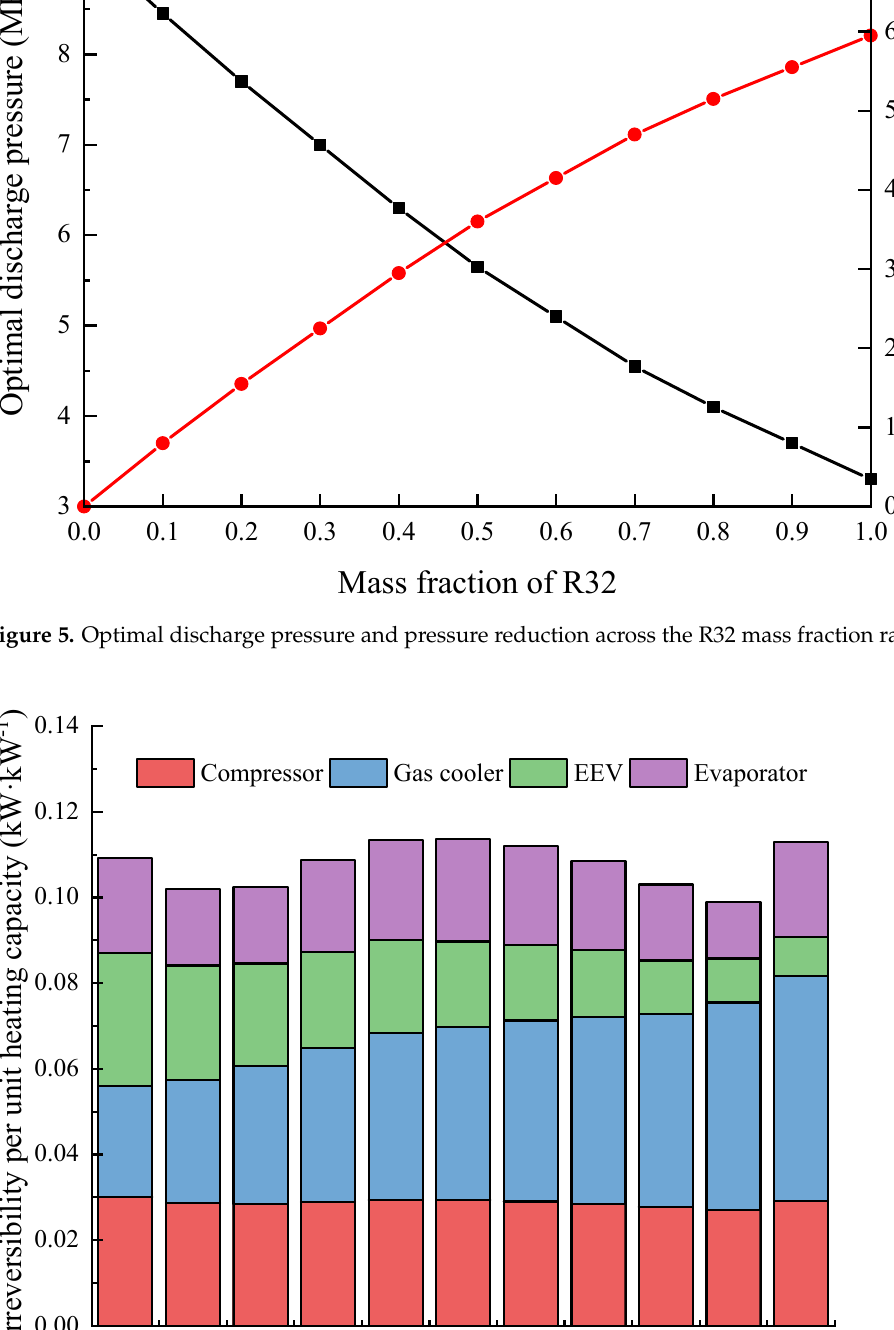
Figure 7. The exergy efficiency with the range of R32 mass fractions. Therefore, based on the results discussed above, an R32 mass fraction of 0.1 to 0.3 is recommended, and the optimal mass fraction of the CO 2 /R32 mixture is 0.9/0.1. A comparison of the temperature-entropy diagram at the optimal system COP and discharge pressure is presented in Figure 8. Figure 8a,b show the transcritical cycles for pure CO 2 and CO 2 /R32 mixture refrigerants, and Figure 8c shows the subcritical cycle with pure R32. Since the temperature difference of the flowing water and ambient air are constant for the three cycles, a better thermal match will certainly result in a better COP.